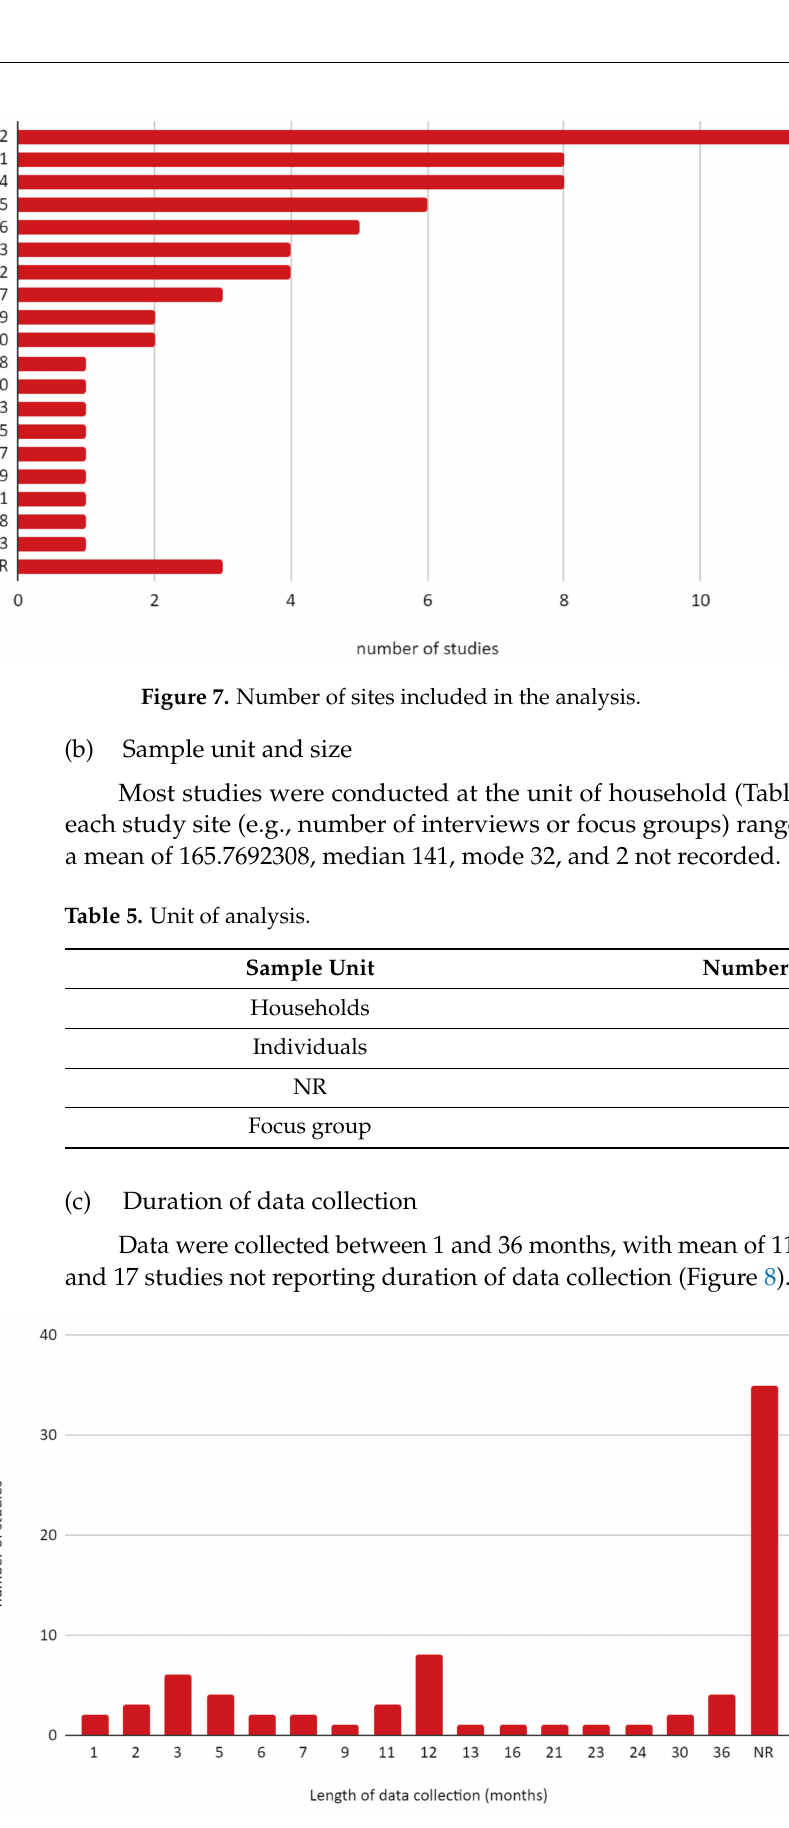
Figure 8. Duration of data